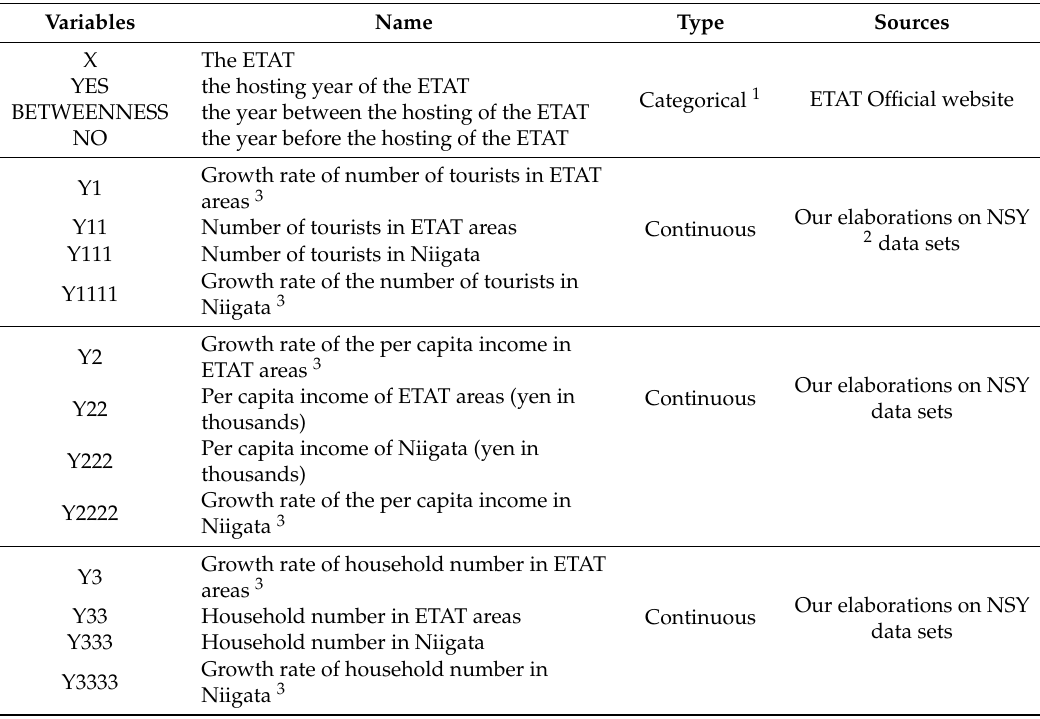
Table 2. Observed variables: Name, type, and data